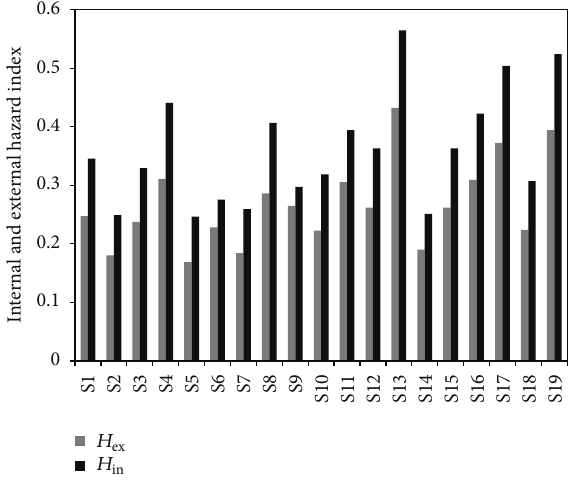
Figure 7: External and internal hazard index for all